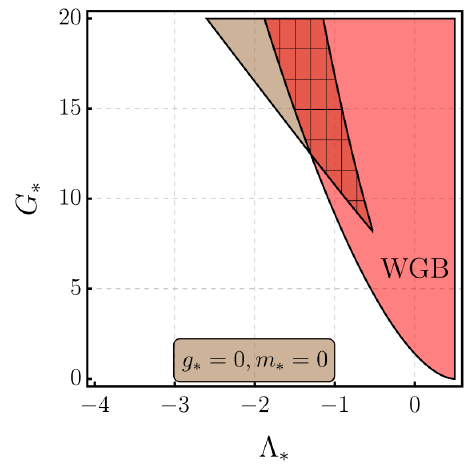
) = (0 , 0) . In the meshed region both m 2 and g 2 are , g 2 ∗ ∗